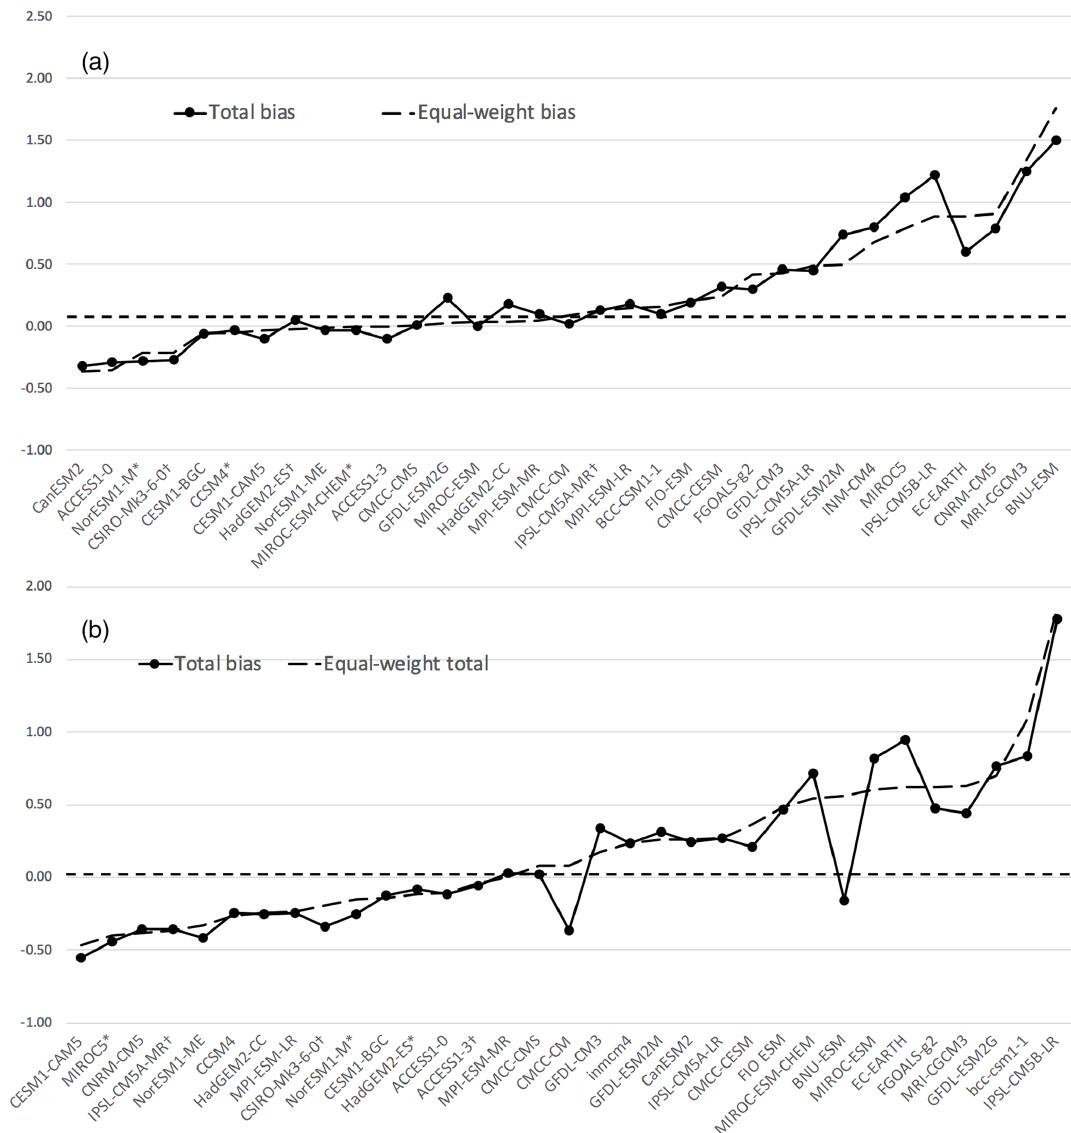
Figure A2. Alternate ranking of AOGCMs according to an equal-weight total bias (dashed black) compared to the realm-averaged total bias (black) over (a) the Antarctic domain and (b) the Greenland domain. The symbols * and † identify models selected in the top three and top six ensembles,